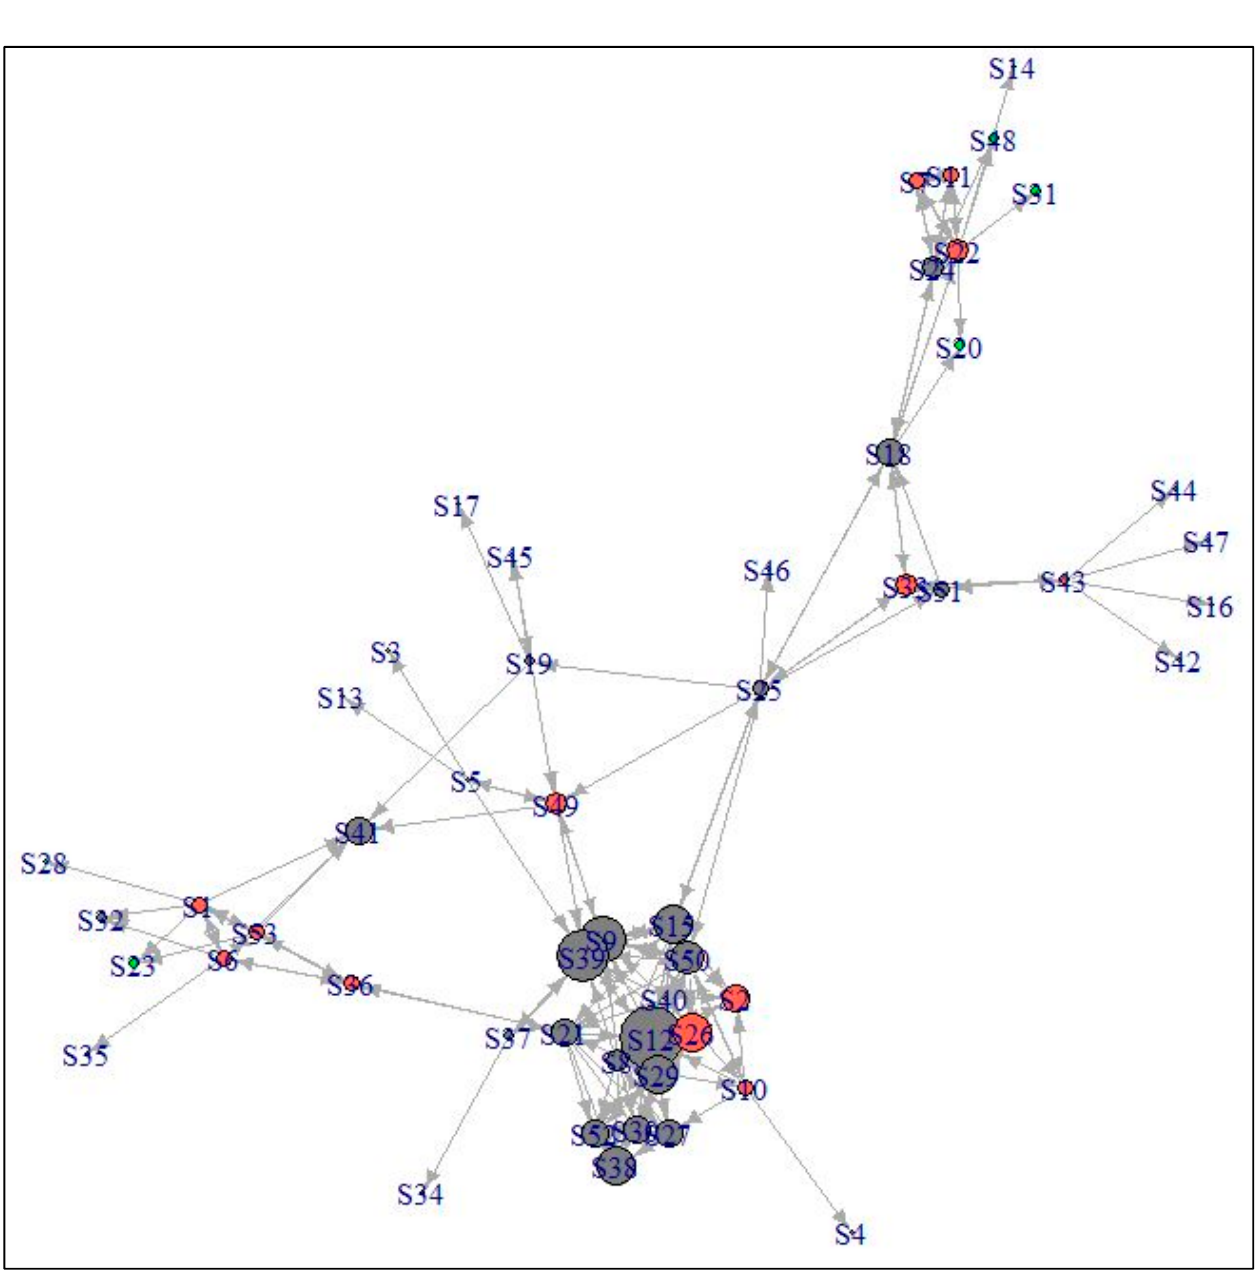
Figure 5. The revised graph visualization with regards to in-degree and test mark rank.